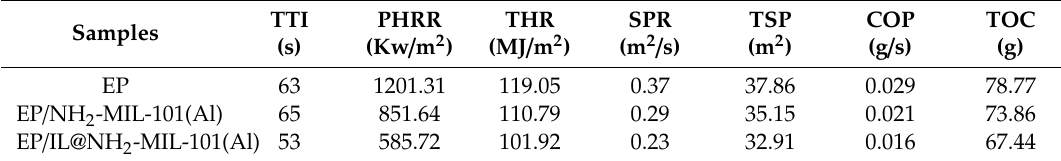
Figure 9. HRR ( a ), SPR ( b ), THR ( c ), TSP ( d ), CO release rate ( e ), and TOC ( f ) curves of EP and EP composites. Table 3. Cone calorimeter data of EP and EP composites.